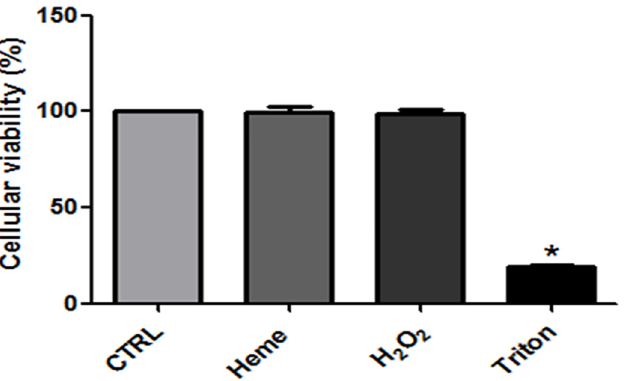
Fig 4. MTT assay for the viability of L . amazonensis incubated with 50 μ M heme and 2.5 μ M hydrogen peroxide. Living parasites were incubated for 1 hour in the reaction medium with the addition of 50 μ M heme or 2.5 μ M H 2 O 2 . Triton 1% was used as a positive control. The values represent the mean ± standard error of at least three independent experiments. * Statistically significant when compared to control (P < 0.05). CTRL,